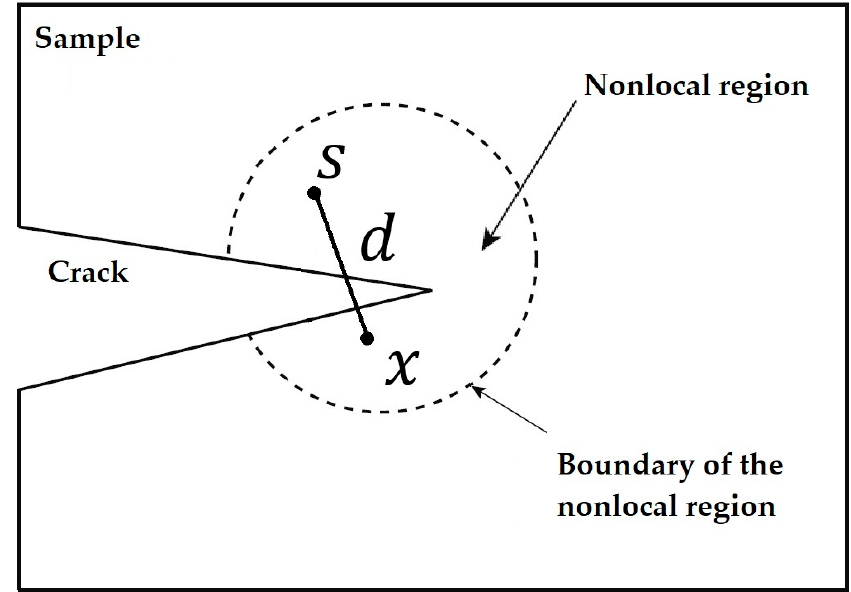
Figure 1. The schematic of a nonlocal region near a crack.